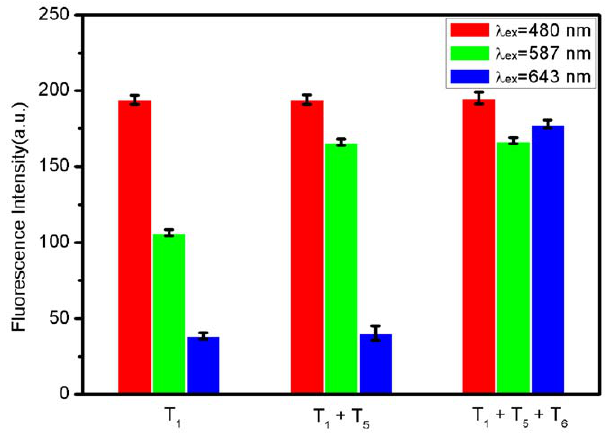
Figure 9. Multiplex DNA detection. Fluorescence intensity histo- grams of the probe mixture toward different target combinations in the presence of RCPNs under excitation/emission wavelengths of 480/518, 587/615, and 643/660 nm/nm. All measurements were done in Tris-HCl buffer in the presence of 15 mM Mg 2 + (pH: 7.4). The error bar represents the standard deviation of three measurements.